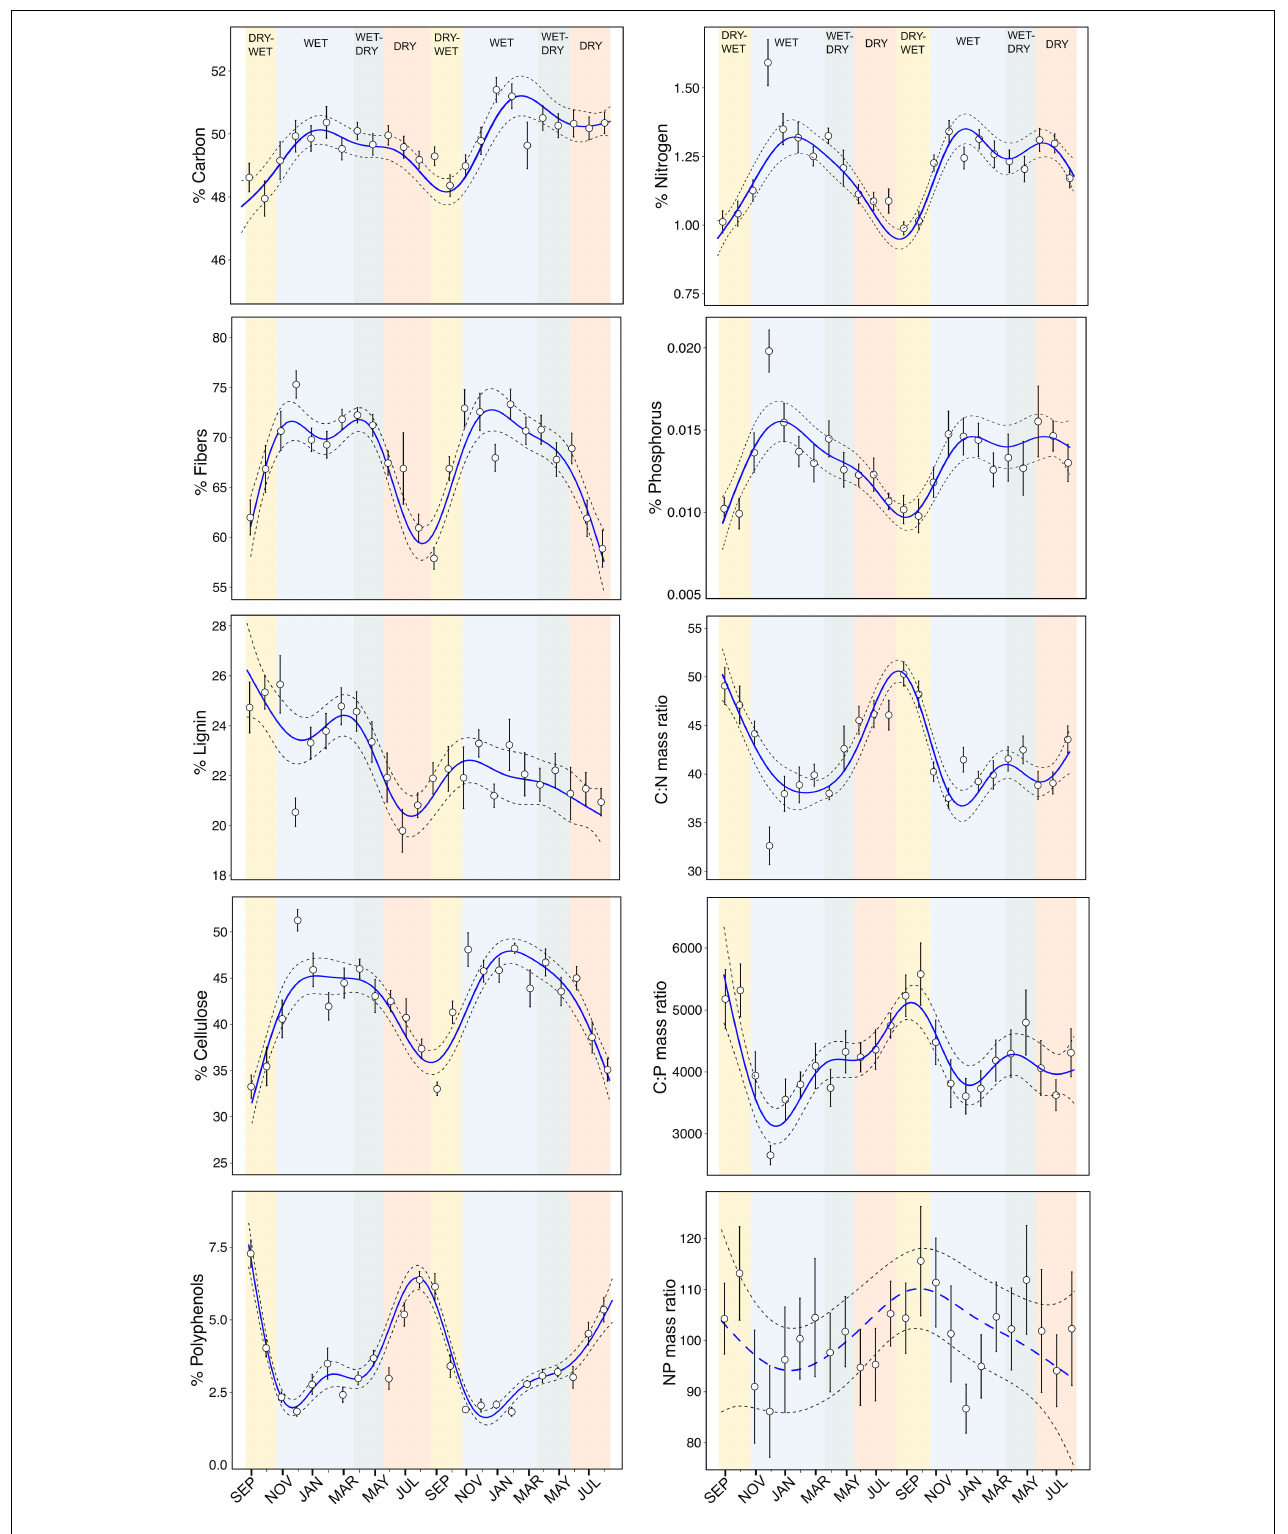
FIGURE 2 | Temporal patterns of litter traits as concentrations of each compound and, ratios of C:N, C:P, and N:P across the four seasons (dry-wet, wet, wet-dry, and dry seasons) over 2 years. Blue lines represent the non-linear temporal trend from generalized additive mixed models and dashed lines the 95% confidence intervals of the models. Circles are means and vertical lines denote upper and lower limits of standard errors from data of multiple sampling sites within streams.